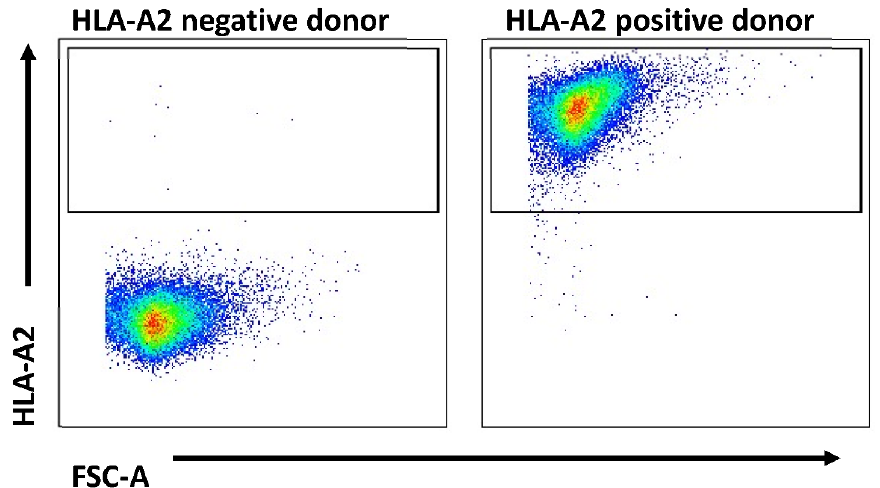
Figure 1. HLA typing of PBMC samples. We predicted SOX11 peptides that bind with HLA-A*0201; therefore, healthy donors were tested for the HLA-A*0201 molecule. The figure shows dot blot results obtained by flow cytometry for an exemplary HLA-A*0201 staining assay. All PBMCs were tested.